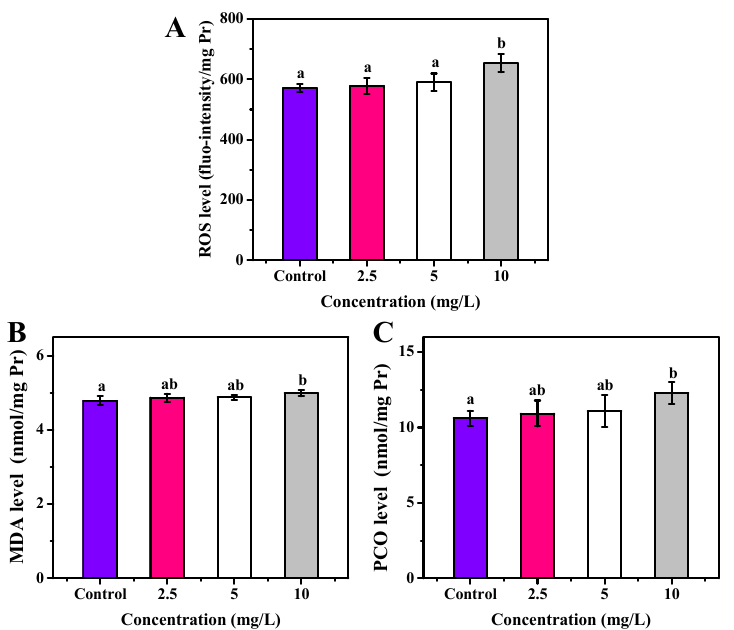
Figure 7. ( A ) ROS, ( B ) MDA, and ( C ) PCO level of zebrafish after exposure to OCNPs in chronic toxicity test. Different letters above columns indicate significant differences ( p < 0.05) between treatments.